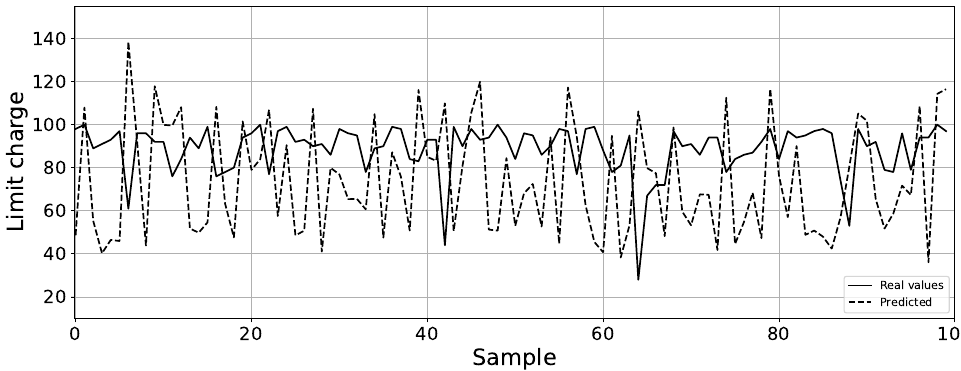
Figure 8. Regression model outcome compared with the limits obtained from